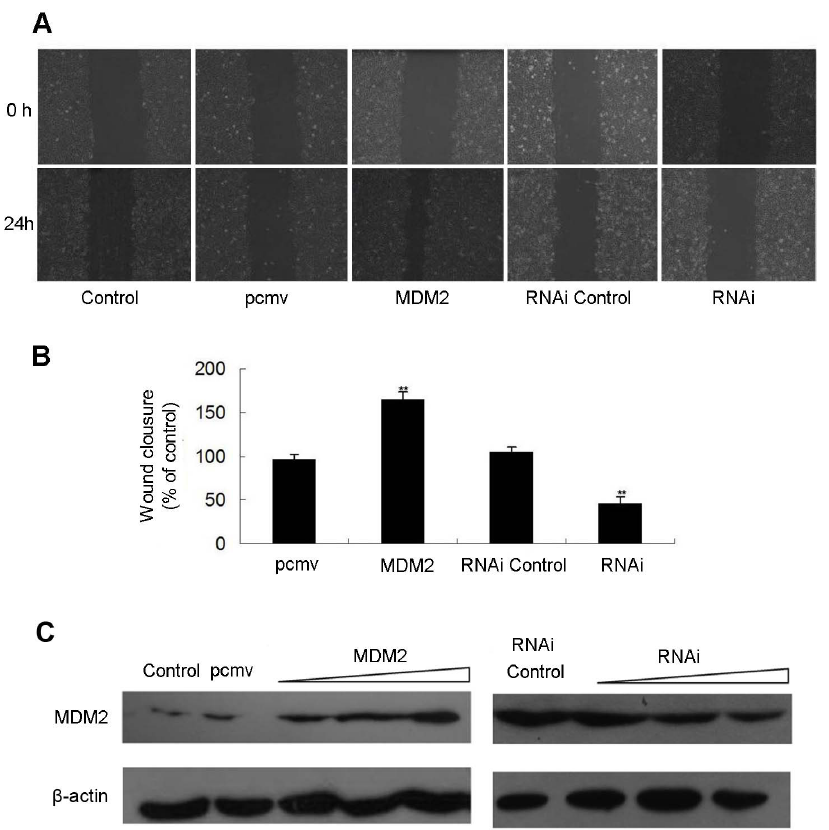
Figure 5. MDM2 promotes the migration of MCF-7 cells. MCF-7 cells were transfected with pcmv-MDM2 expression plasmids and pcmv vectors or siRNAs against MDM2 and non-specific siRNA (controls); after 24 h, the cells were scraped with a sterile pipette tip to create a wound. (A) Wound closure was observed by phase-contrast microscopy and photographed at 0 and 24 h. (B) The wound area was measured by the Adobe Photoshop software. Wound closure was quantified as the mean 6 standard deviation of three independent experiments. The control wound closure was set at 100%, and the MDM2 treatments are represented as the percent of the control. (C) The levels of MDM2 protein were detected using Western blot analysis in MCF-7 cells that over- or under-expressed MDM2 (plasmid or siRNA transfection) and control cells. b -actin levels served as internal control.